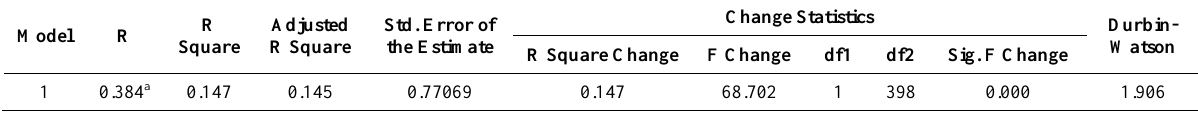
Table 7. Model Summary for digitalization and customer loyalty